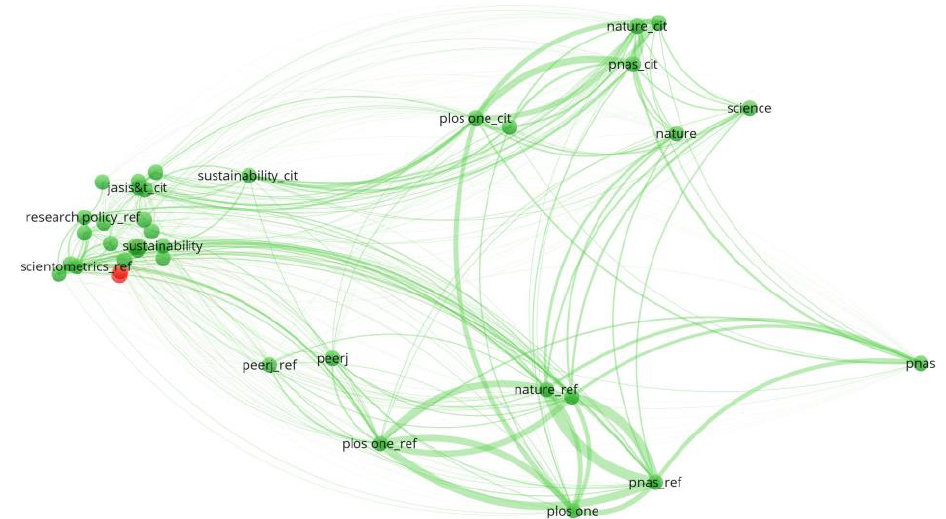
Figure 2. Total network showing the references and citations of Publications and related journals. Node size corresponds to the number of publications. Source: VOSViewer.